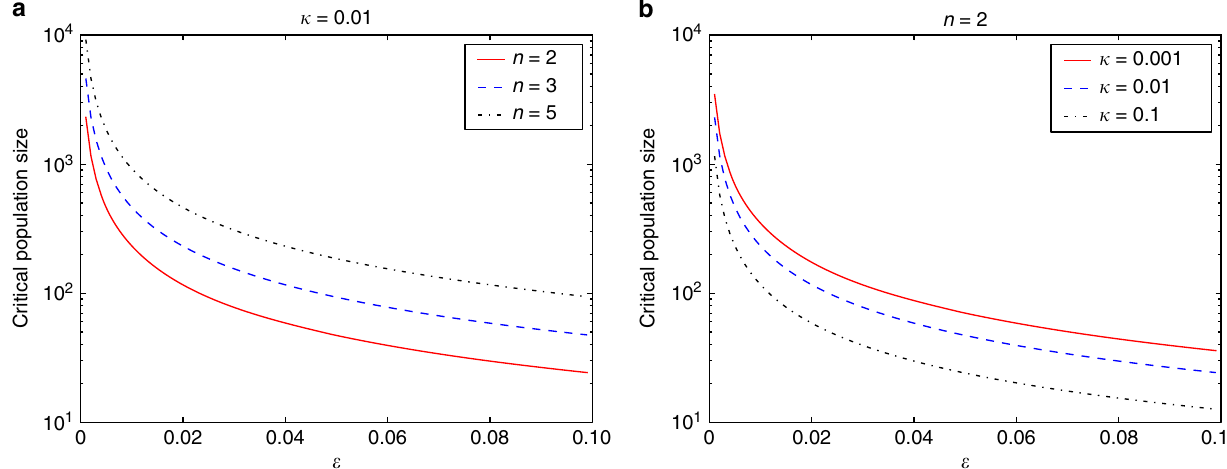
Fig. 3 Critical population size for shift between robust and fragile peaks. a Results for various n values with κ = 0.01. b Results for various κ values with n =